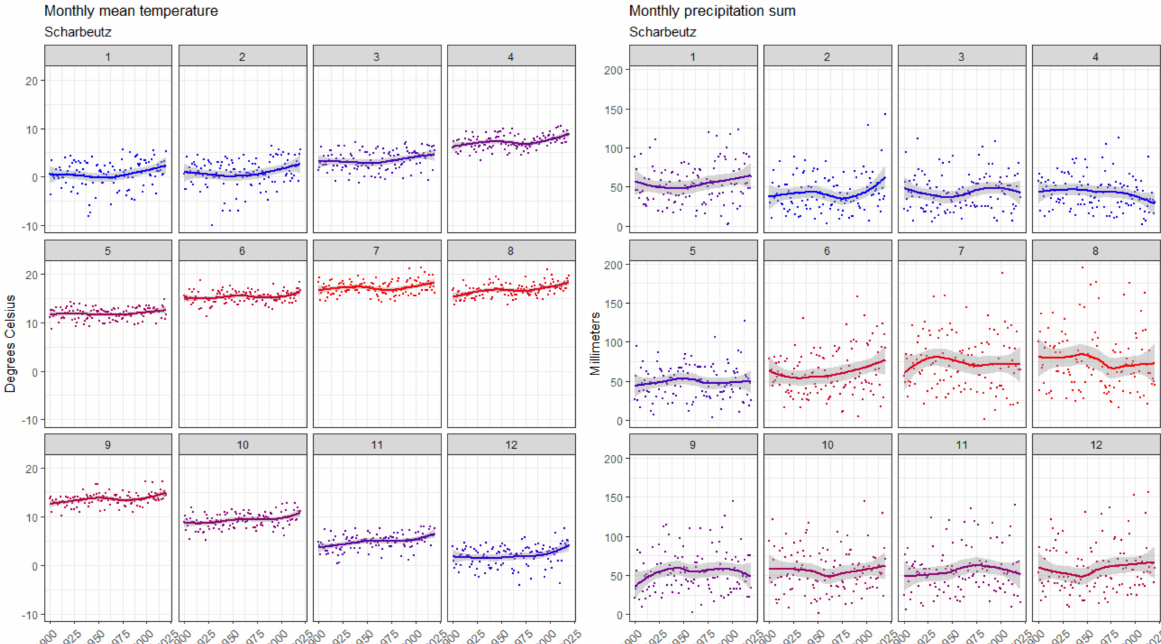
Figure 4. Plot of individual month summary of the monthly mean temperature ( left ) and monthly mean of precipitation ( right ) for the study area (Scharbeutz, northern Germany). Months are repre- sented as a number (for instance; January is represented as 1, and December as